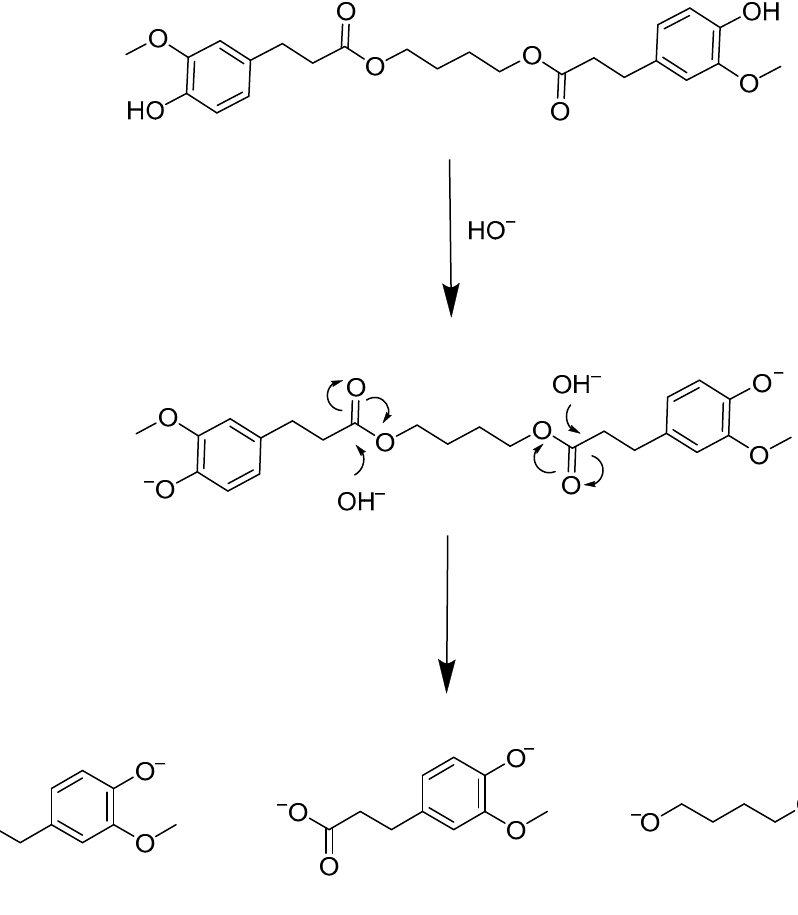
Figure 3. Saponification reaction with BDF.